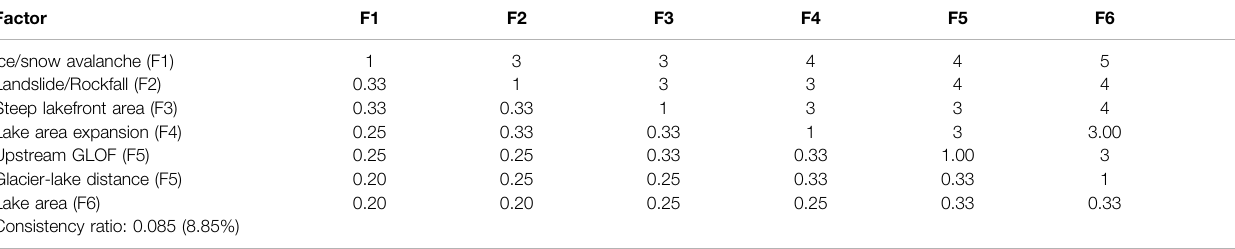
TABLE 3 | Pairwise comparison of outburst factors and consistency ratio based on AHP. Factor F1 F2 Ice/snow avalanche